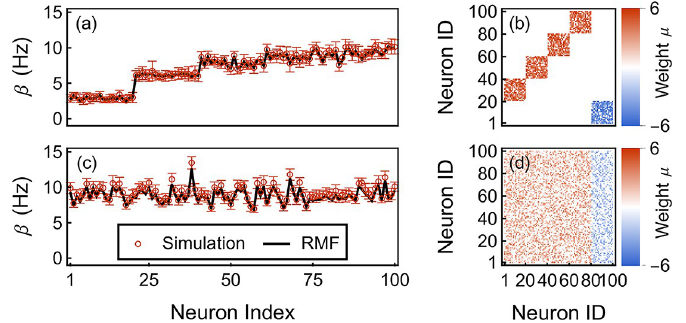
Fig 9. Comparison of RMF and simulated rates in inhomogeneous networks. Two networks of 80 excitatory and 20 inhibitory neurons are considered. In panel (a), the network is feedforward with 4 excitatory layers and one last inhibitory layer inhibiting the first layer. The neurons between layers are connected with probability 75% and the synaptic strengths are uniformly random between 3 and 6, as shown in (b). Panel (c) and (d) are for a network with no particular structure. Each pair of neurons is connected with probability 50% and the synaptic strengths are uniformly random between 0 and 4. For the simulated data, we run the event-driven simulation until 40000 spiking events for the entire network are accumulated. This process is repeated 32 times. During each repetition, we record the total time T k ( k = 1, ��� , 32) and spiking event count S i , k for each neuron i ( i = 1, ��� , 100). The mean firing rates of neurons are P 32 computed by � b ¼ ð = T Þ = 32 . The standard deviation of the rates (indicated by error bars) over these 32 trials S i i ; k k k ¼ 1 P 32 are computed by ð ð S = T Þ 2 (cid:0) � b 2 Þ = ð 32 (cid:0) 1 Þ . Parameters: a = 0.1, h = 5 Hz, τ = 10 i ; k k i k ¼ 1